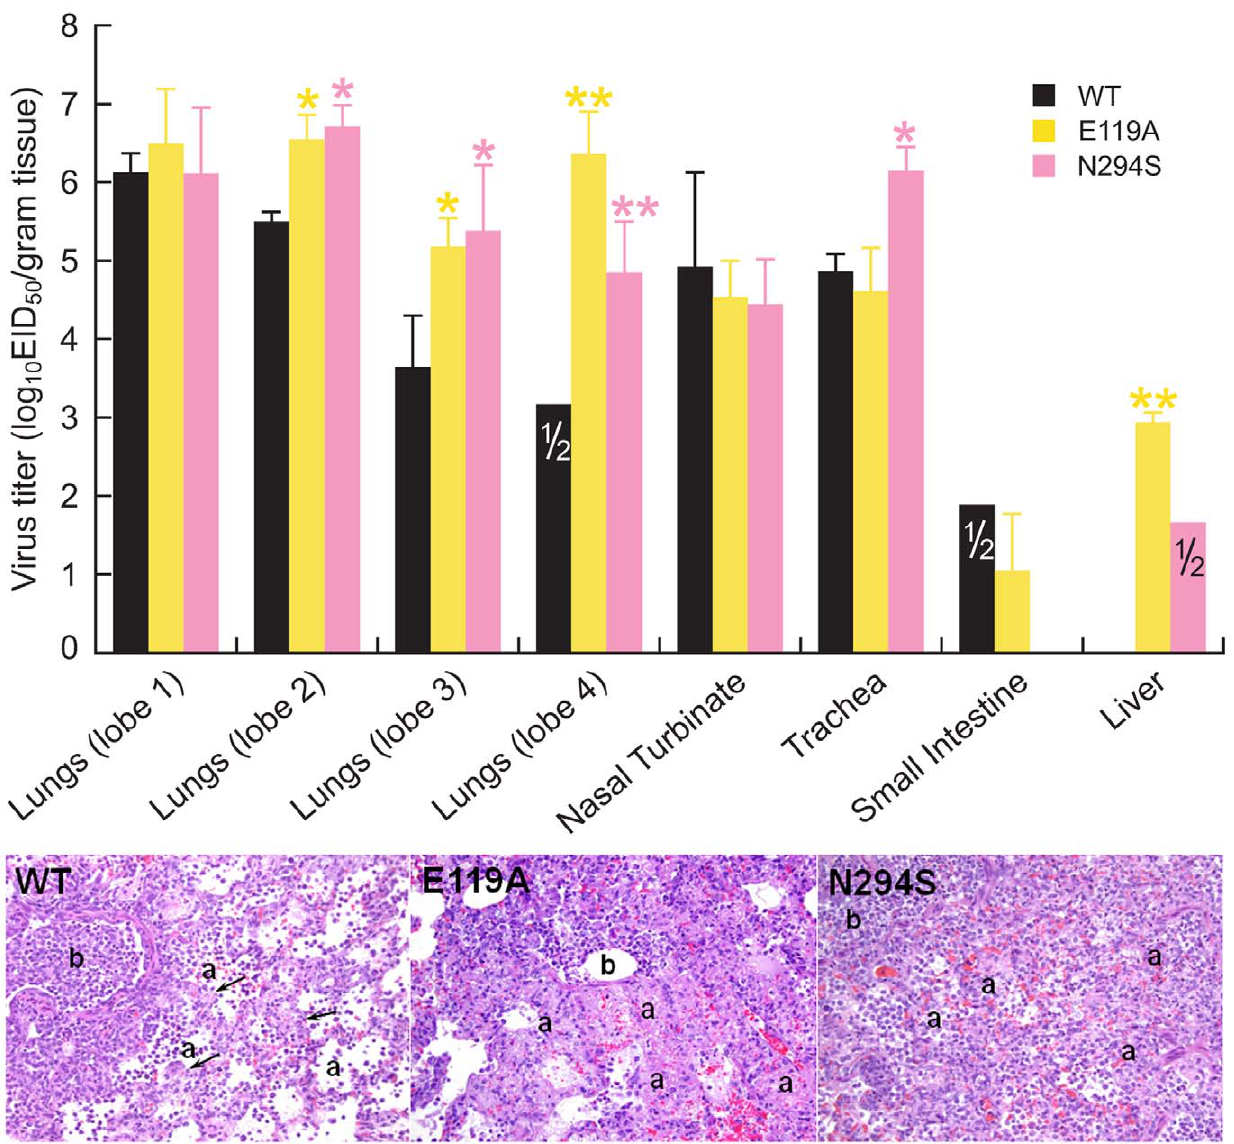
Figure 4. Replication of recombinant WT, E119A, and N294S viruses in internal organs and histologic changes in the lungs morphology of ferrets infected with these H5N1 viruses. (A) Virus titers were determined for the lungs (4 lobes tested separately), nasal turbinates, tracheas, small intestines, and livers of ferrets on day 4 post-inoculation. Values (log 10 EID 50 /gram tissue) are the mean 6 s.d. for two ferrets, unless it is indicated that the virus was detected in one of two ferrets. *, P , 0.05, **, P , 0.01 compared to WT virus (one-way ANOVA). (B) The images shown are hematoxylin-and-eosin-stained sections of lung tissue from ferrets inoculated with the WT, E119A, and N294S viruses obtained on day 4 post-inoculation. Lung showing bronchiole (b) with epithelial necrosis, intraluminal debris, and inflammatory cells. Lung alveoli (a) of the WT- infected ferrets are lined with interstitial septa (arrows) and have mild to moderate inflammatory cell infiltrates. The lung alveolar architecture of the ferrets inoculated with the E119A mutant is lost due to necrosis of alveolar pneumocytes and the interstitial septa. Lung alveoli of the N294S-infected ferrets are filled with inflammatory cells and hyperplastic pneumocytes obscuring interstitial septa. Magnification, 6 20.